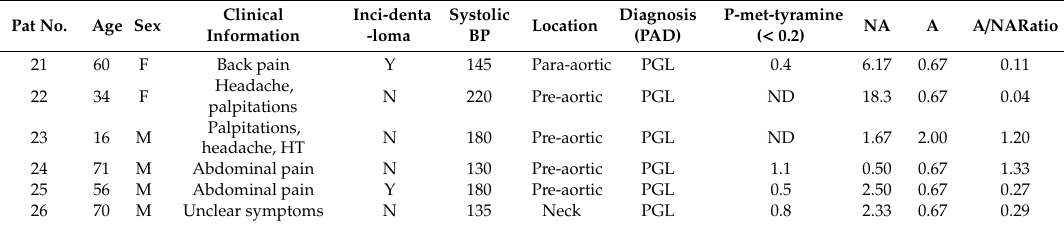
Table 4. CT characteristics and PET / CT parameters in six patients with 11 C-HED uptake in extra-adrenal sites that, after surgery, were histopathologically confirmed as paragangliomas (PGL). HT; hypertension, BP; blood pressure, ND; not done, HU; Hounsfield Units, CECT; contrast-enhanced CT, A; epinephrine, NA;